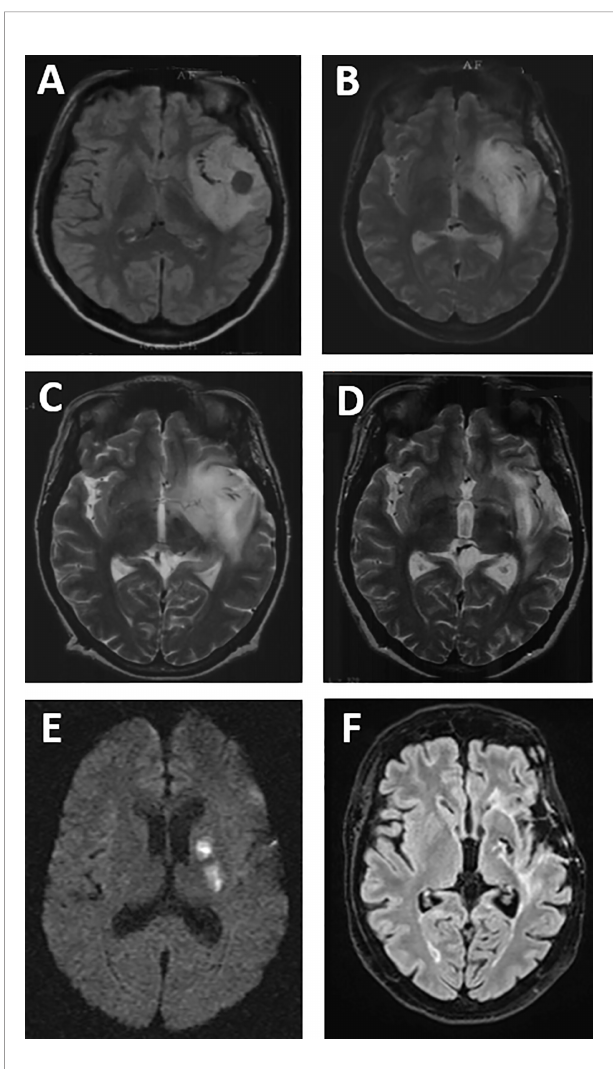
FIGURE 2 | Example of MRI response and complication, in left temporal IDH/noncodeleted DLGG, in FLAIR (A, F) , T2-weighted (B – D) , and diffusion- weighted imaging (E) . Precise (A) at diagnosis and after biopsy. (B) MRI before PCV and 3 months after partial resection. (C) MRI after PCV (before RT). (D) MRI after RT (after PCV + RT). (E) MRI 6 years after the end of PCV + RT (stroke lesions). (F) MRI 19 years after the end of PCV + RT and 25 years after